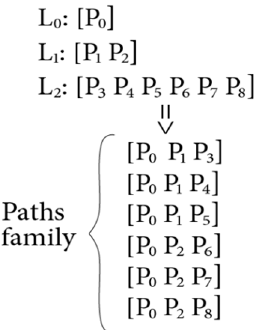
Electronics 2020 , 9 , x FOR PEER REVIEW Figure 10. Point layers to control points conversion [22]. Figure 10. Point layers to control points conversion [22].